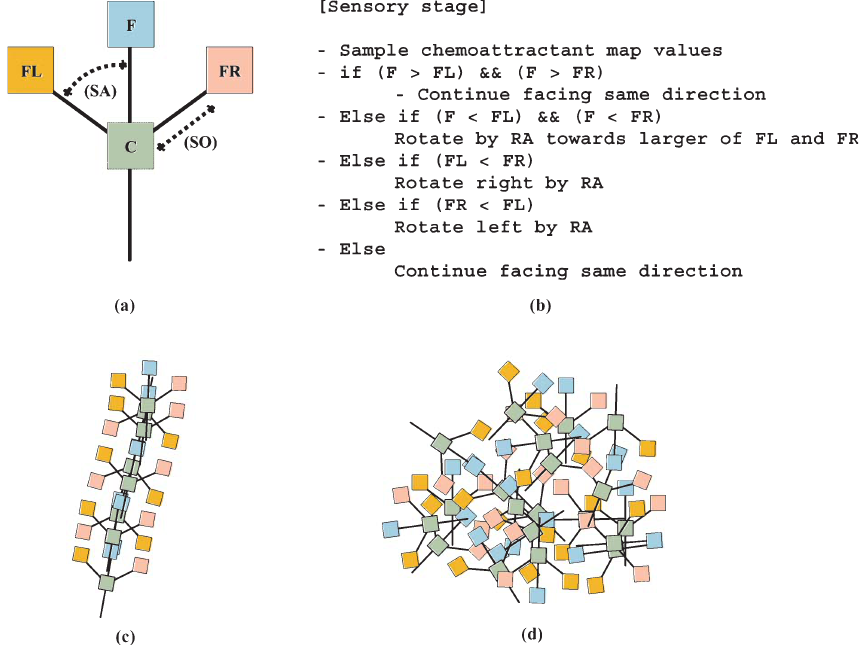
Fig. 8. Agent particle morphology, algorithm, and aggregation